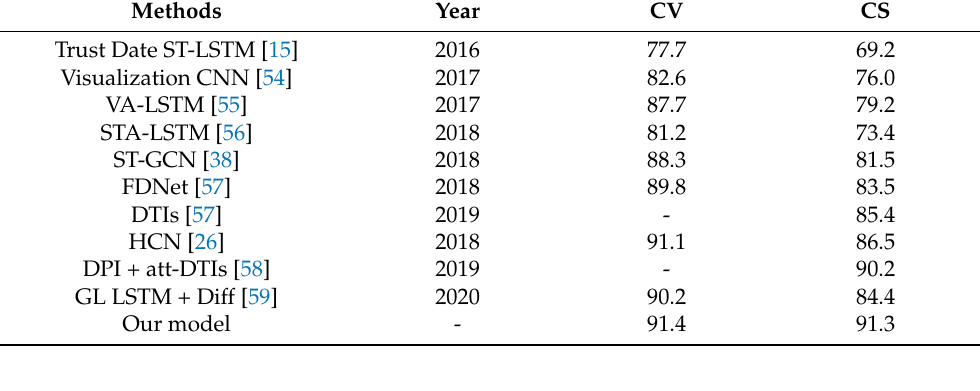
Table 3. NTU RGB+D dataset showing an accuracy (%) comparison with previously proposed meth- ods for cross-view (CV) and cross-subject (CS) evaluation.